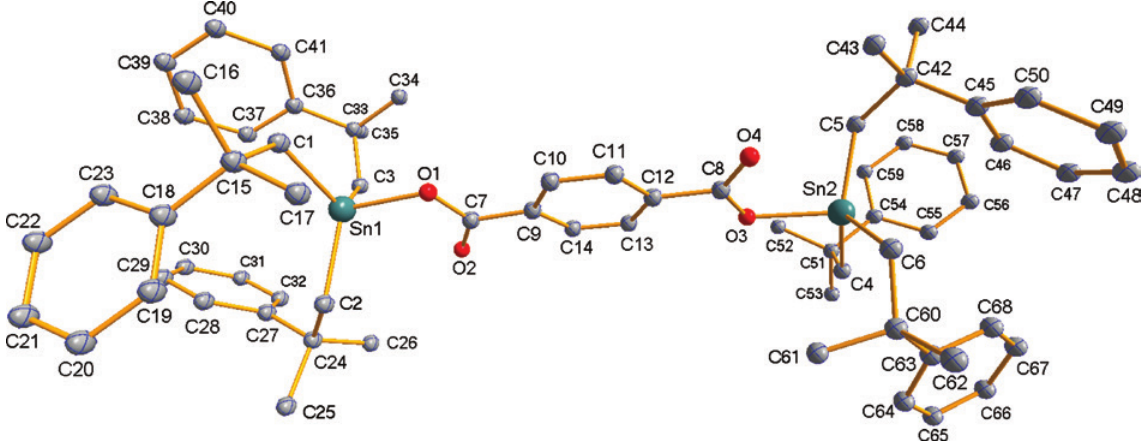
Figure 2: The molecular structure of 2 . Displacement ellipsoids are drawn at the 30% probability level; hydrogen atoms are omitted for clarity.